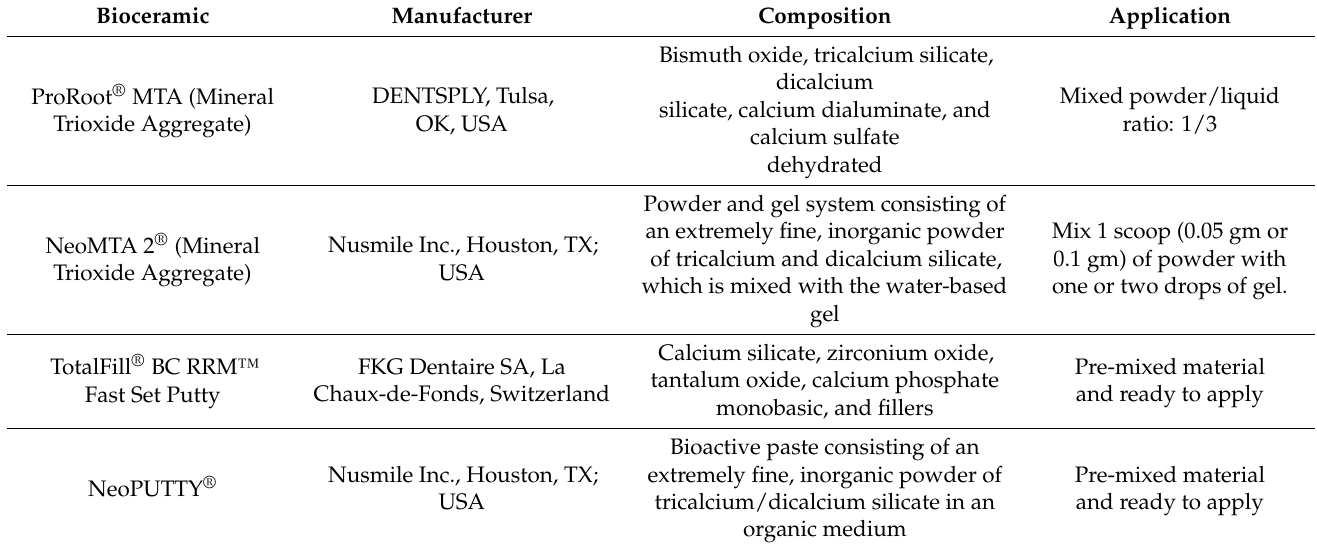
Table 2. Chemical composition and application procedure of bioceramic materials according to the manufacturer’s